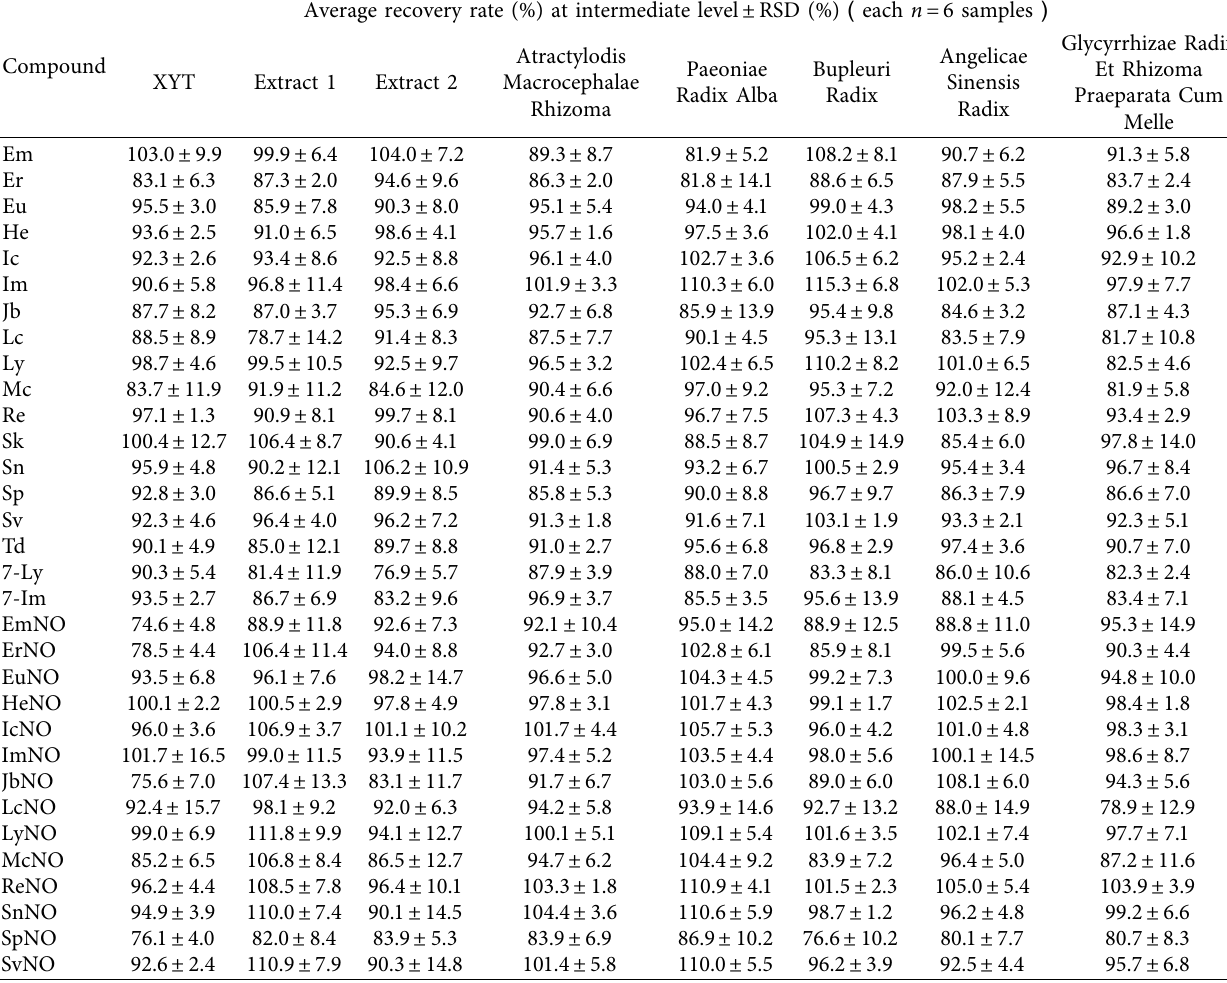
Table 4: Mean recoveries and precision of the method for PAs in various matrices.